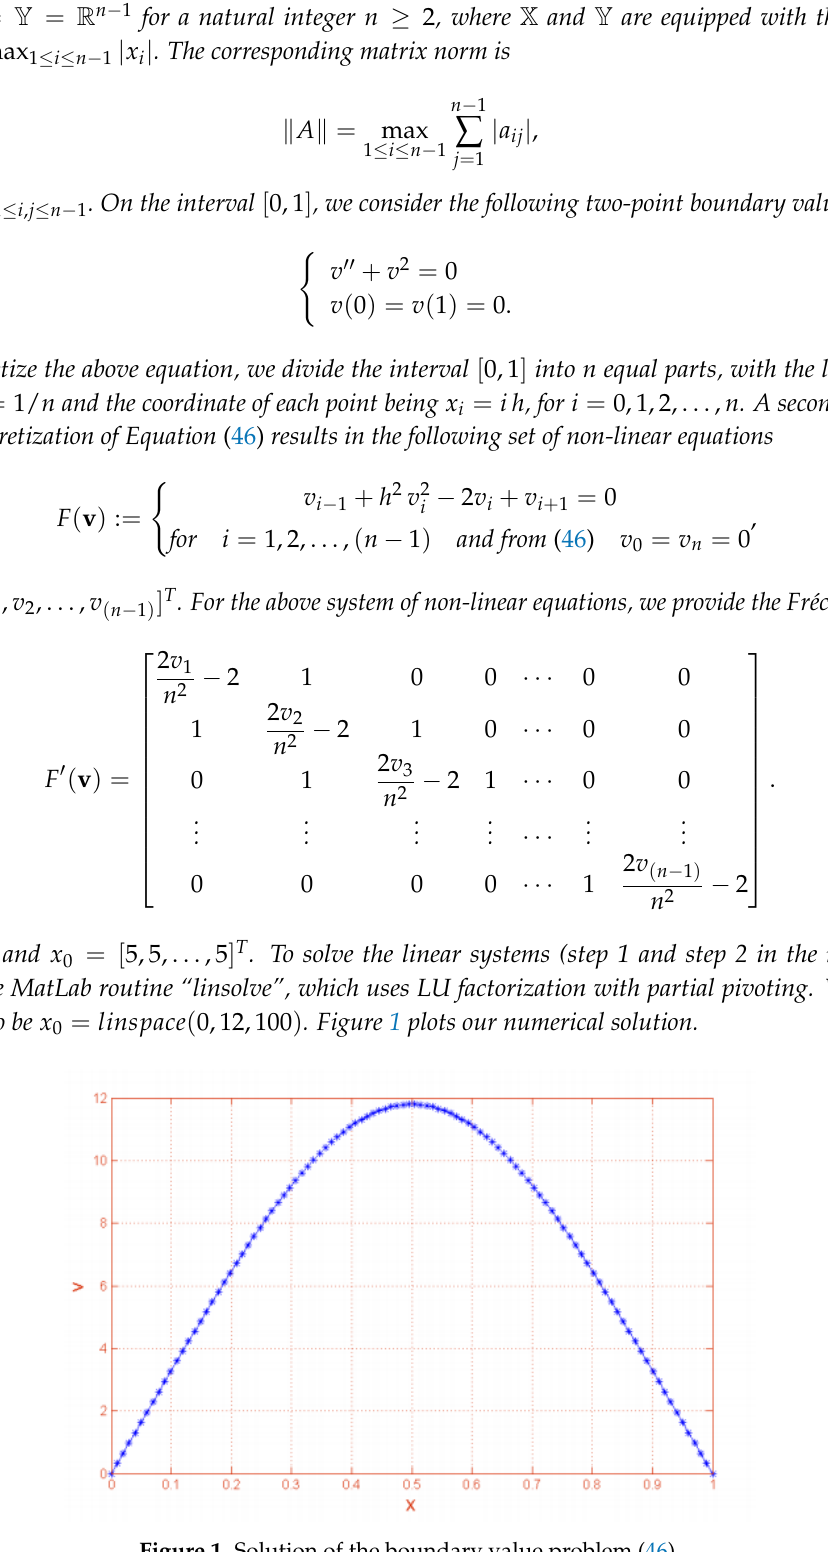
Figure 1. Solution of the boundary value problem